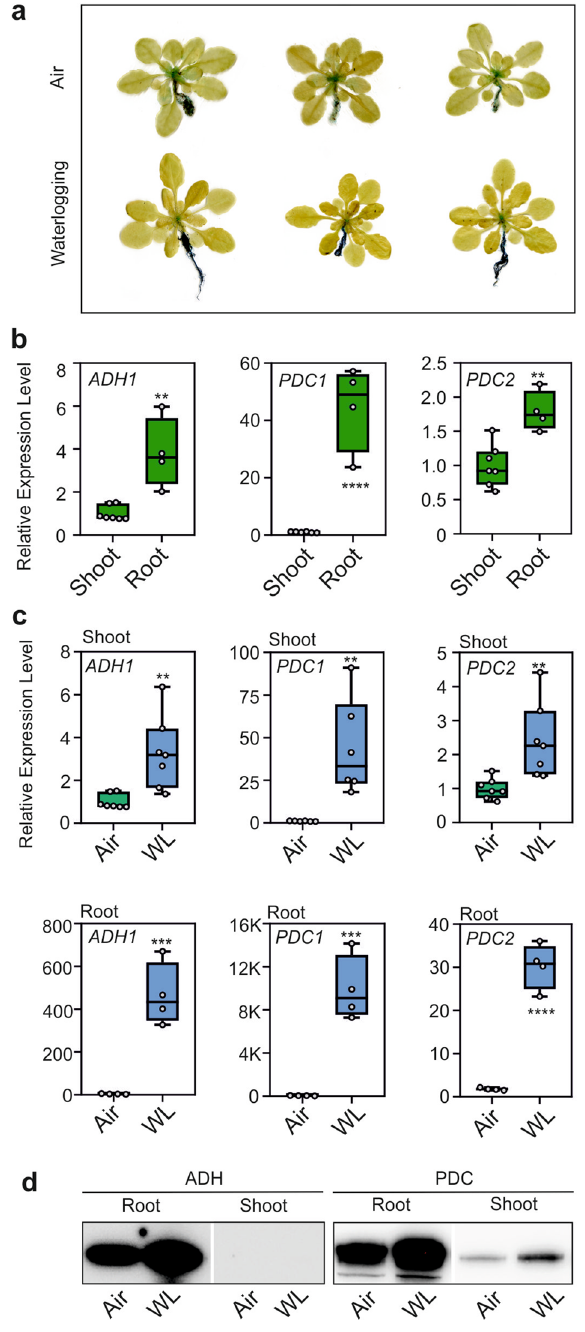
Figure 7. Expression of ADH1 and PDC1 in aerobic and waterlogged Arabidopsis plants. ( a ) GUS staining of pADH1:GUS plants in air or 5-day waterlogging. ( b ) Comparison of the expression (RT-qPCR) of ADH1 , PDC1 , and PDC2 in roots and shoots of aerobic plants. ( c ) Comparison of the expression (RT-qPCR) of ADH1 , PDC1 , and PDC2 in air (green box) vs. 5-day waterlogging (WL, blue box). Lines in the boxes indicate the median. The bottom and top of each box denote the first and third quartile, respectively. The dots represent the single data points and whiskers denote the min/max values. Statistically significant differences are indicated by an asterisk ( T test, pairwise comparison at each time point, * = p < 0.05; ** = p < 0.01; *** = p < 0.001; **** = p < 0.0001). ( d ) Immunoblot analysis of proteins in aerobic and waterlogged plants. Equal loading was verified by protein staining (Figure